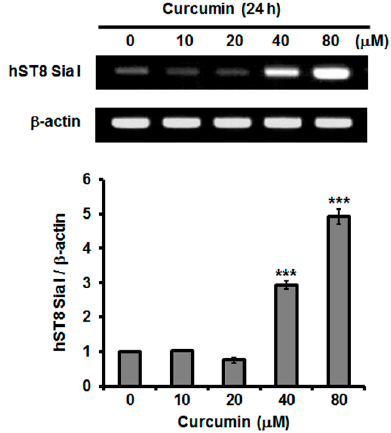
Figure 3. Effect of curcumin on mRNA levels of hST8Sia I. Total RNA from A549 cells was isolated after incubation at different concentrations (0–80 μ M) for 24 h and mRNA level of hST8Sia I was assessed by reverse transcription polymerase chain reaction (RT-PCR). The housekeeping gene β -actin was used as an internal control. All error bars are expressed as mean ± SEM of two independent experiments. *** p < 0.0001 compared with 0 μ M.